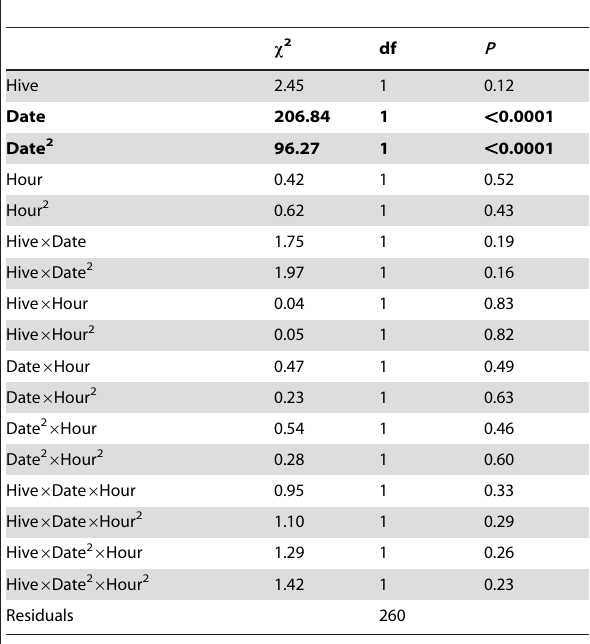
Table 2. Summary of the GLM (Poisson family) of the diurnal and seasonal variation of Apis mellifera flying activity during Vespa velutina predation.